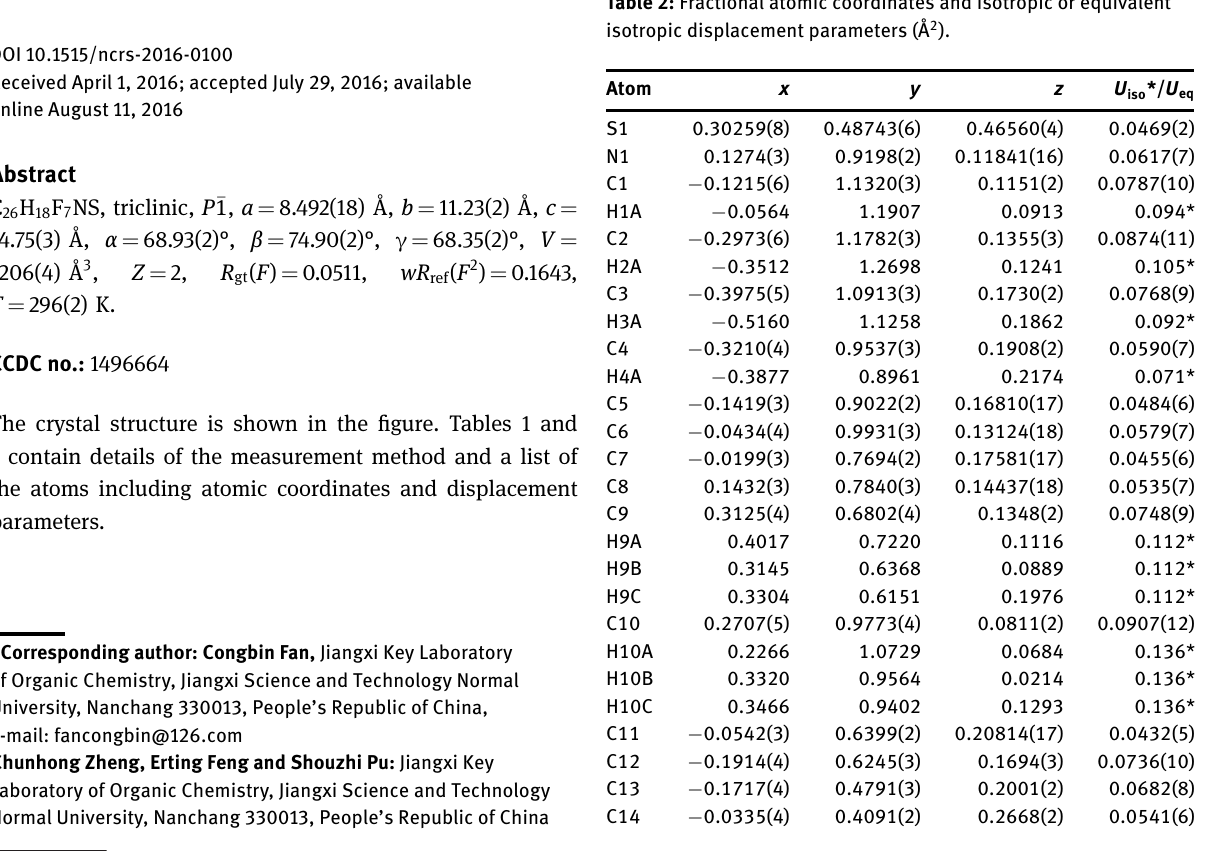
Table 2: Fractional atomic coordinates and isotropic or equivalent isotropic displacement parameters (Å 2